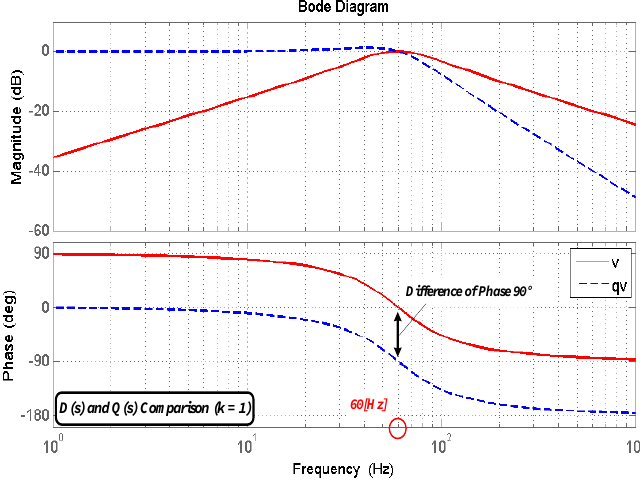
Figure 8. Comparison of transfer function D ( s ) and Q ( s )